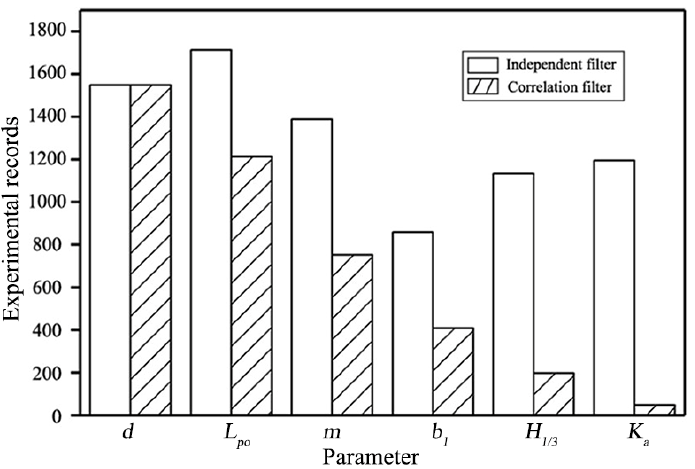
Figure 9. Result of all datasets filtered by the Equations (6) and (7).